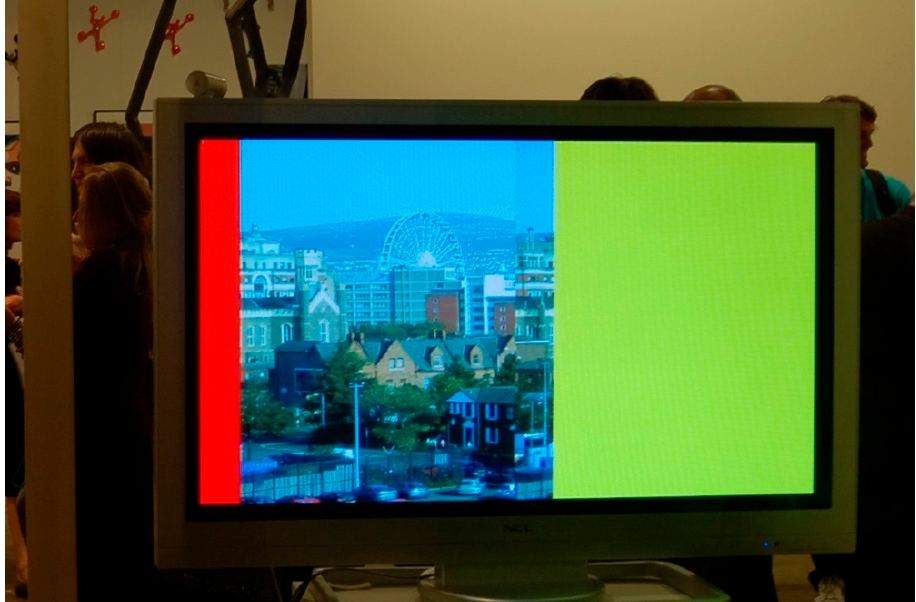
Figure 9. Cities Tango in Sydney. 2009. Photo Ernest Edmonds. © Ernest Edmonds. Arts 2019 , 8 , x FOR PEER REVIEW